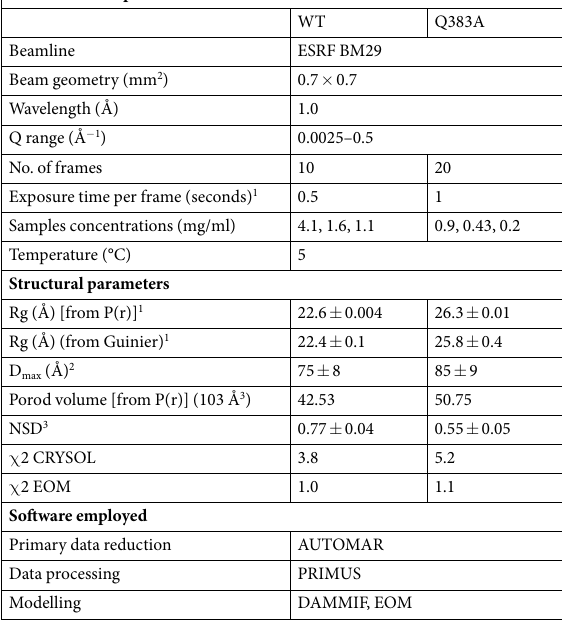
(Figs 4f and g, Table 2). Moreover, the molecular envelope calculated for Q383A was in poor agreement with the crystal structure (Fig. 4h), further confirmed using CRYSOL ( χ 2 = 5.2; Fig. 5a, Table 2). Importantly, EOM analy- sis of Q383A revealed sampling of a different conformational space region (Fig. 5b and c), with predominant and more discrete elongated conformations frequently populated (Fig. 5e). Hence, perturbation of the hydrogen bond between the TRX and α domains results in significant changes to the structure of mCLIC6.